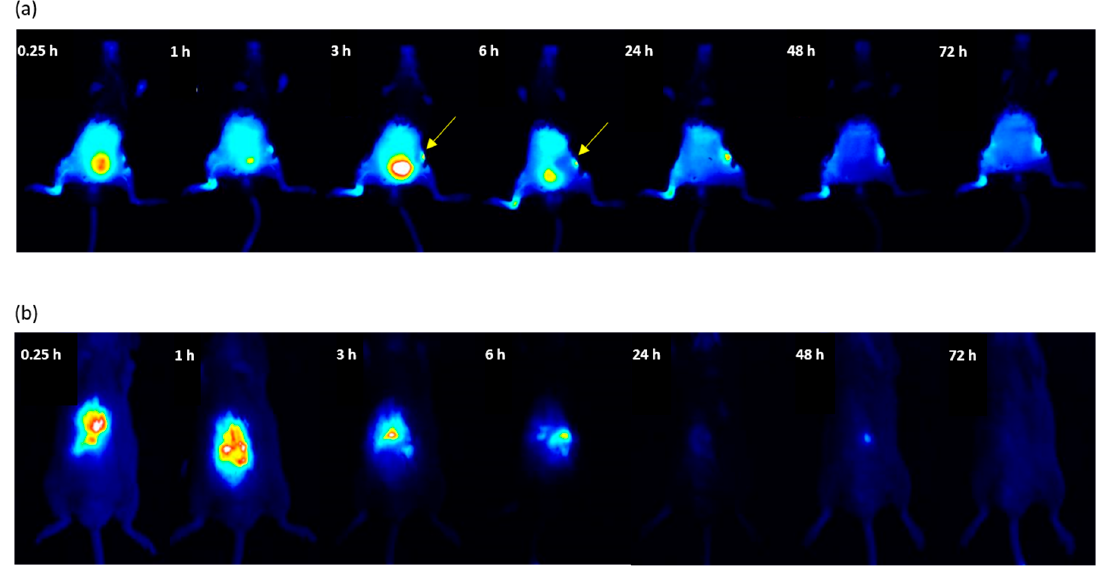
Figure 3. In vivo biodistribution of copolymer conjugate liquid chromatography (LC)-Cy5.5-DEX- OPB_i.v. ( a ) and fluorescent dye Cy 5.5, ( b ). Injection of the 0.1 mg Cy5.5 eq/kg, n = 6. The yellow arrows signify the copolymer conjugate accumulation in the inflamed skin after irritation by depilation and scratching.